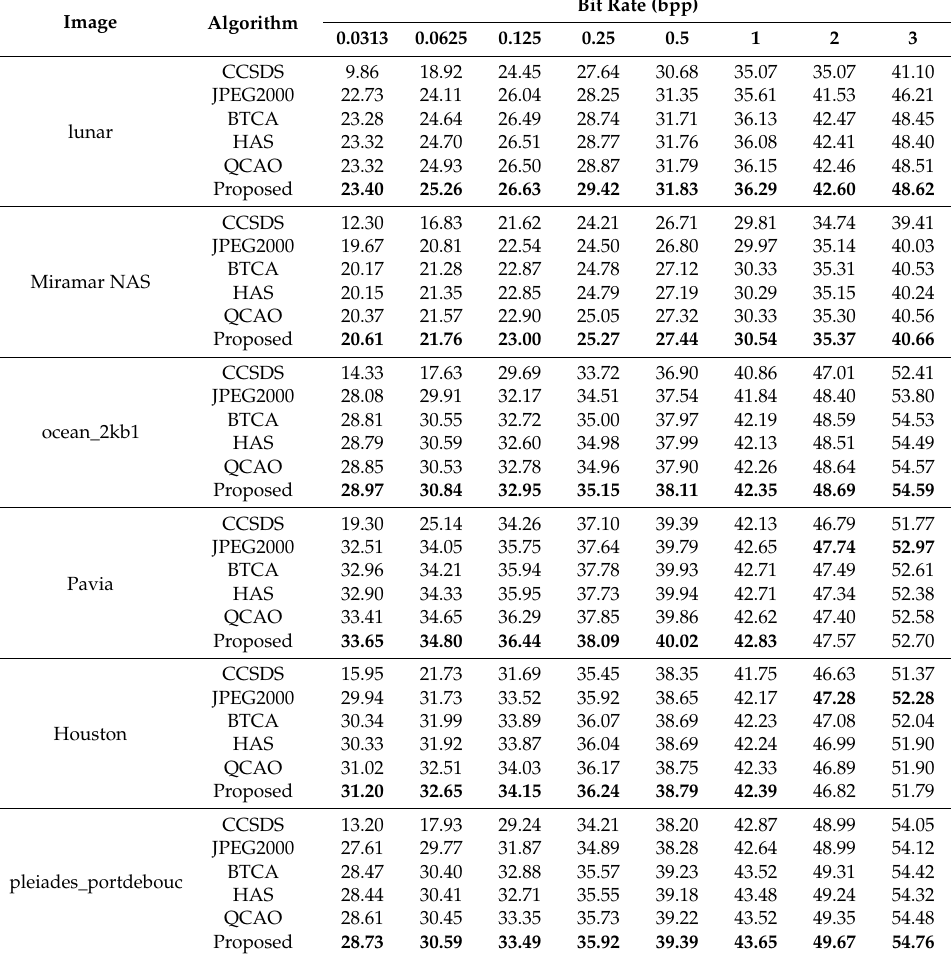
Table 3. PSNRs (dB) of the proposed compression method and other scan-based compression methods.